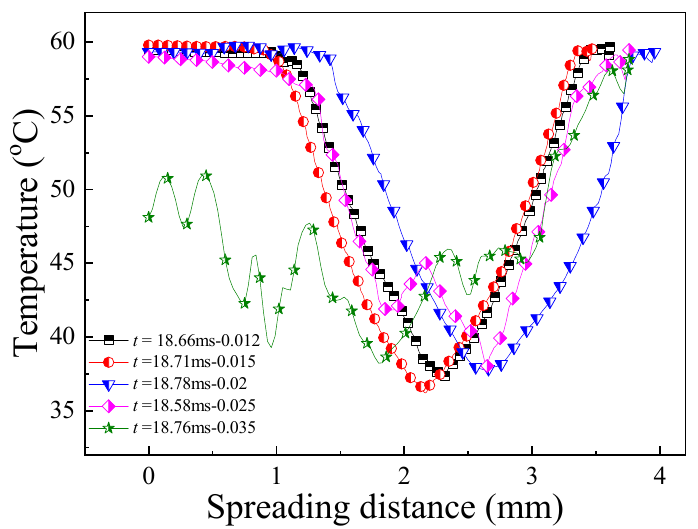
Figure 10. Mesh checking results: the comparison of radial temperature distribution on the air-liquid interface of simulation for W e = 16, T w = 60 °C.